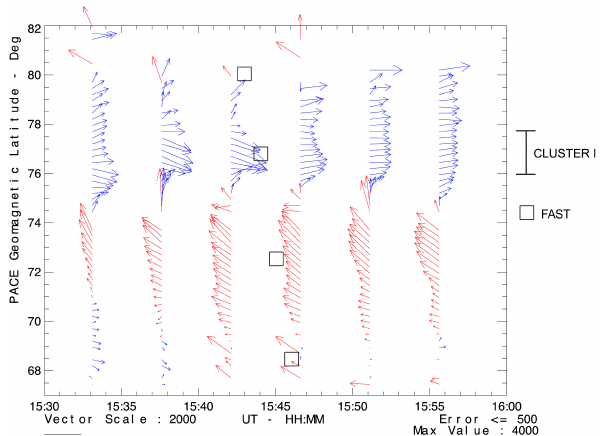
Fig. 13. Ion drift velocities from the Søndrestrøm radar between 15:30–16:00 UT. A clear convection reversal boundary may be seen between latitudinal sectors of noonward (sunward, red) and tailward flow (violet). Note the boundary corrugations. Tailward flows of the order of 2km/s − 1 are observed poleward of the convection re- versal. These flows are being seen at the footprint of Cluster at 15:40–15:45